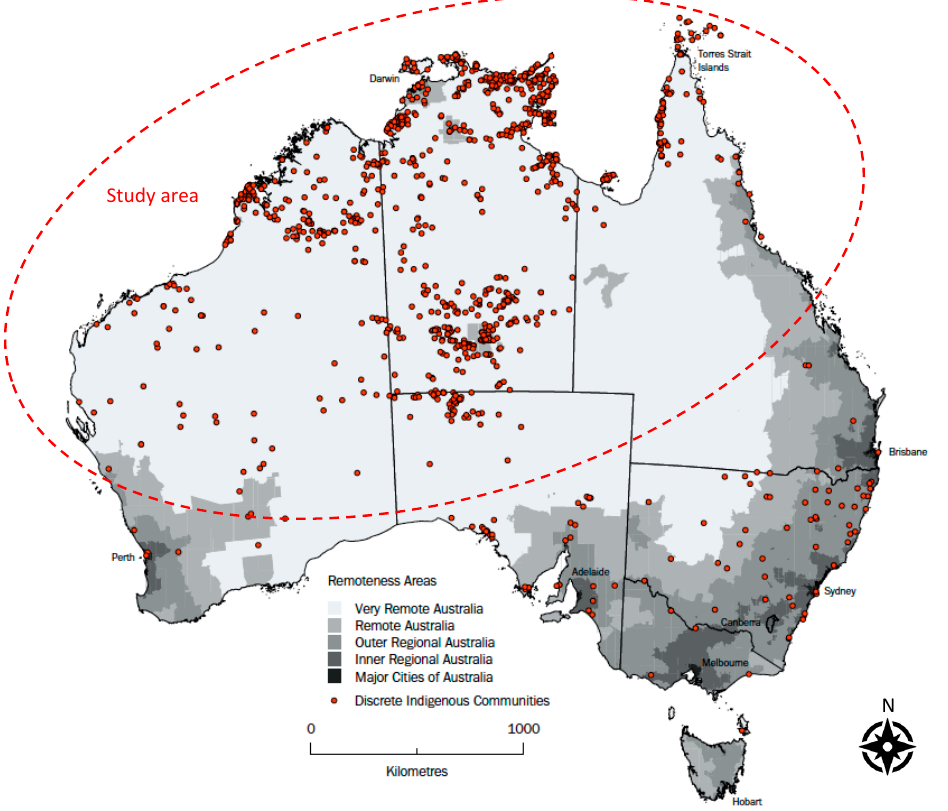
Figure 2. Study area overlaid on map of discrete Indigenous communities (reproduced with permission: [83]).